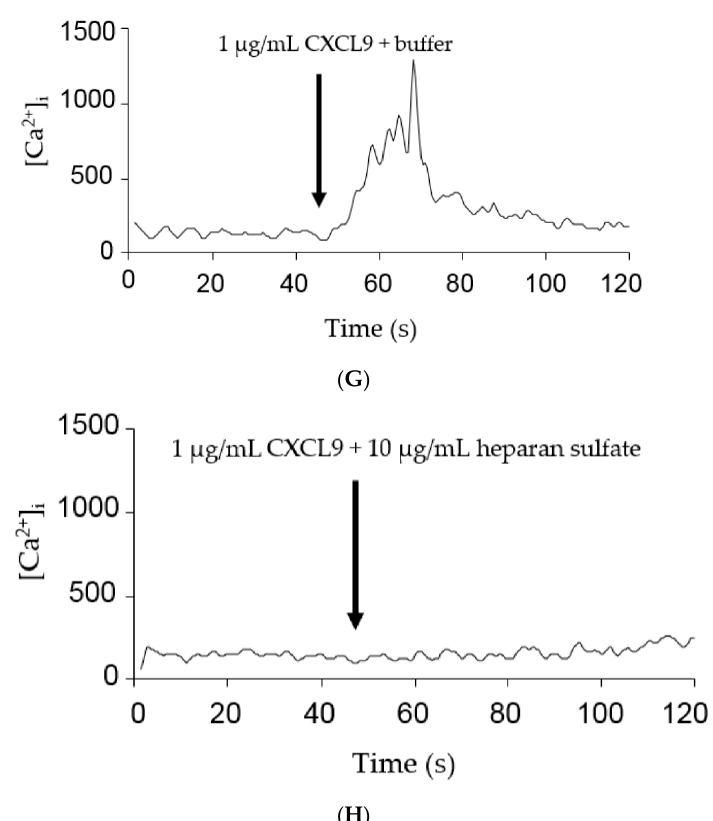
Figure 3. Effect of heparan sulfate on chemokine-induced calcium signaling through CXCR3. CHO/CXCR3A cells were stimulated with 3 ng/mL: CXCL10 ( A – D ); or CXCL11 ( E , F ); or 1 µg/mL CXCL9 ( G , H ) in the presence or absence of GAG. [Ca 2+ ] i concentrations were calculated using the equation of Grynkiewicz et al. Figures show representative experiments in which cells were simultaneously stimulated with chemokine and buffer ( A , E , G ); or 0.04 µg/mL ( B ); 2 µg/mL ( C ); or 10 µg/mL ( D , F , H ) heparan sulfate.